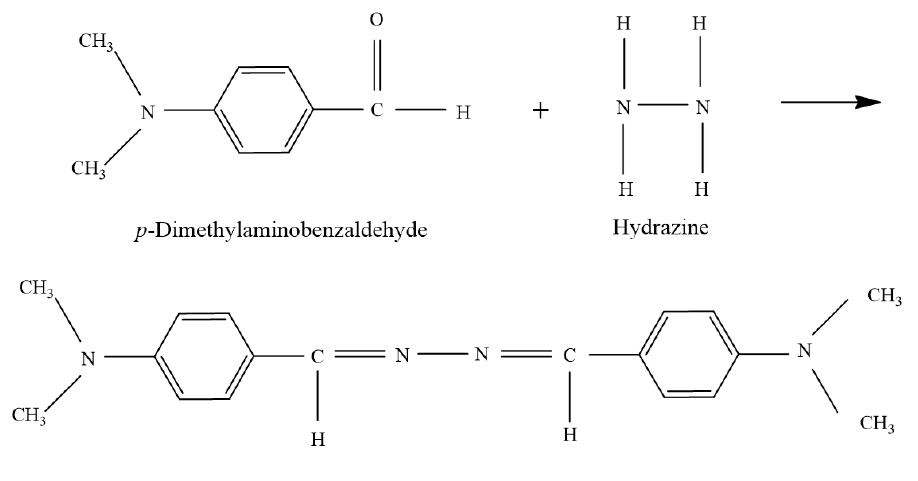
Figure 4. Proposed mechanism of hydrazine